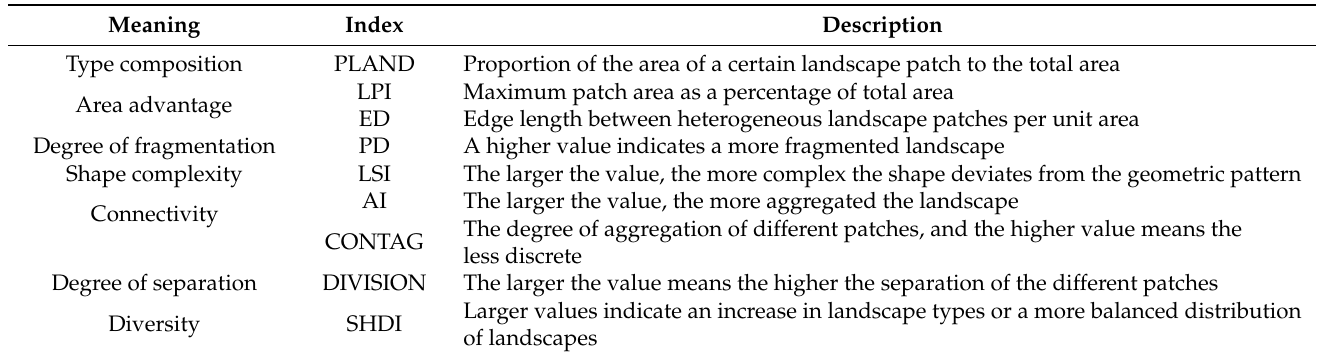
Table 1. Meaning and description of landscape pattern indexes.